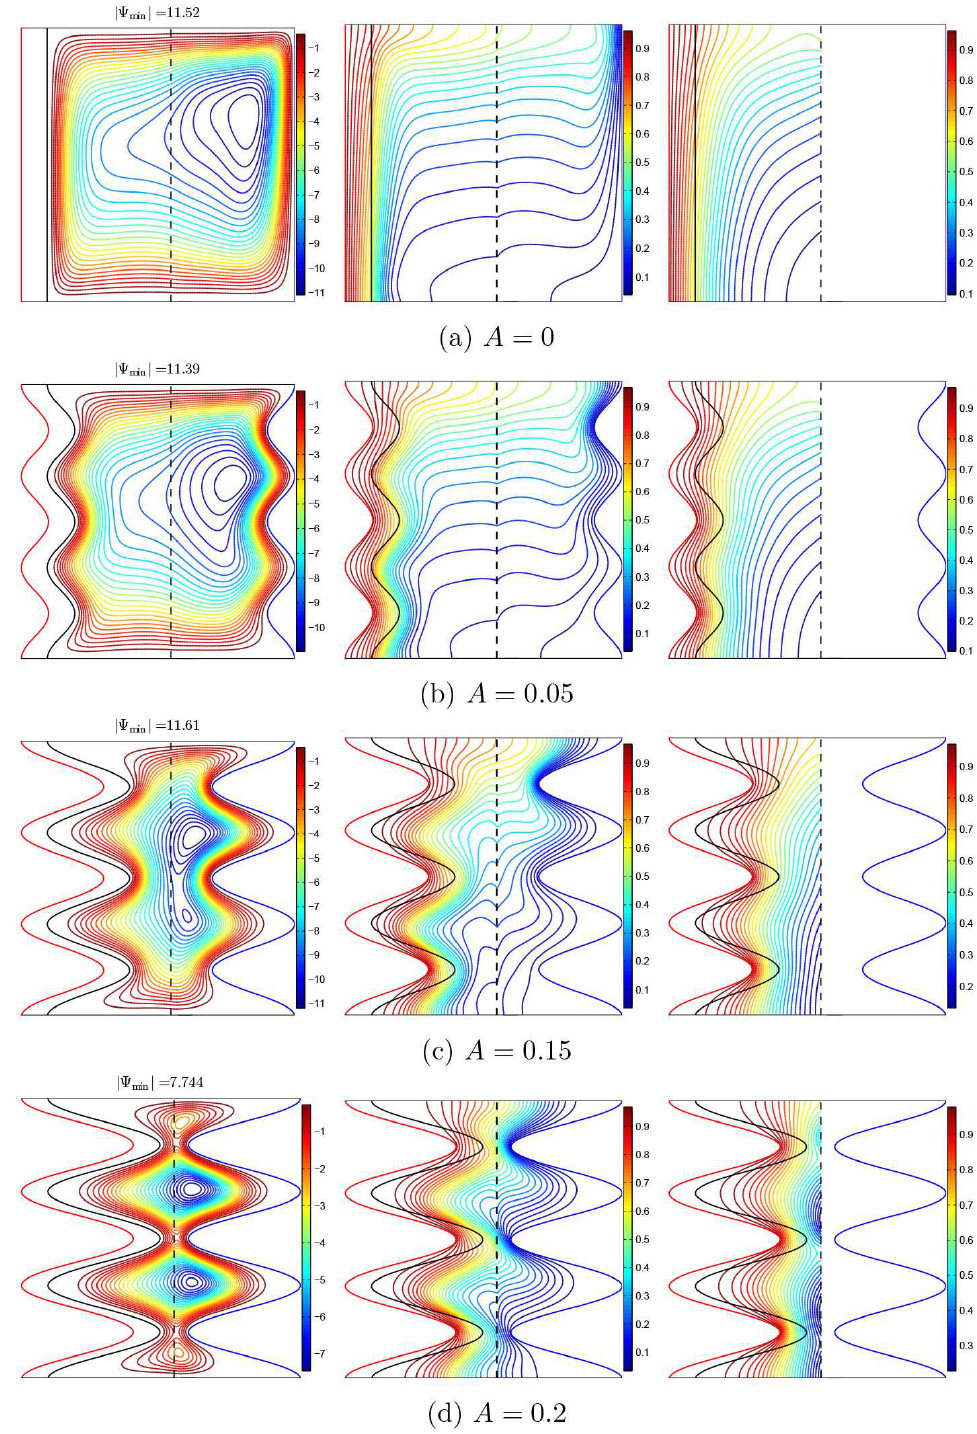
Figure 9. Streamlines ( left ), the isotherms of the nanofluid phase ( middle ), and the isotherms of the solid phase ( right ) with various amplitudes ( A ); Da = 10 − 3 , φ = 0.02, γ = 10, and ε =